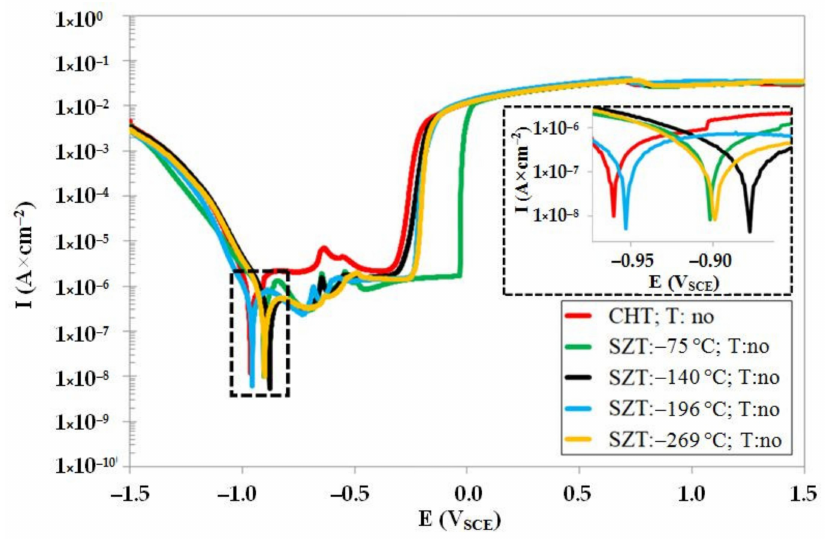
Figure 7. Potentiodynamic polarisation curves of CHT and different SZT specimens in un-tempered